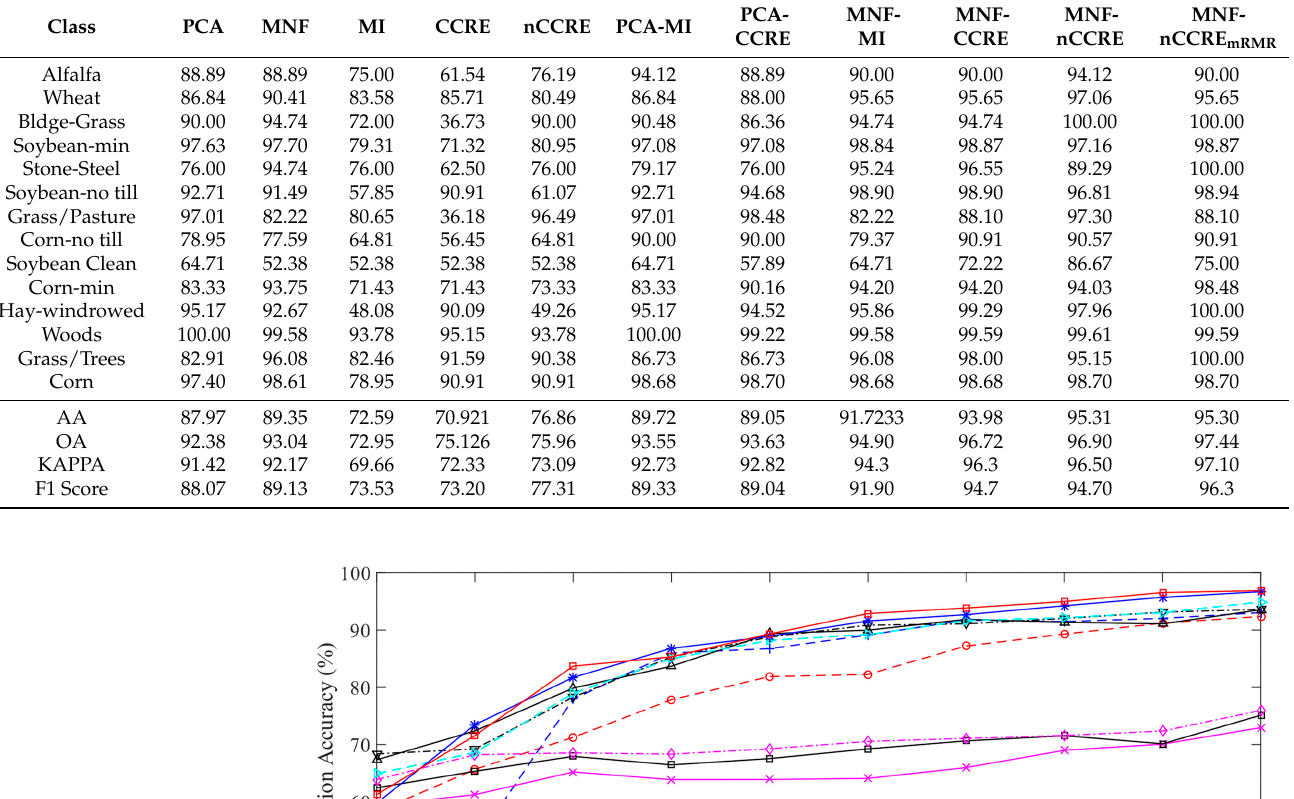
Table 9. Classification performance measure (%) on the AVIRIS IP HSI.